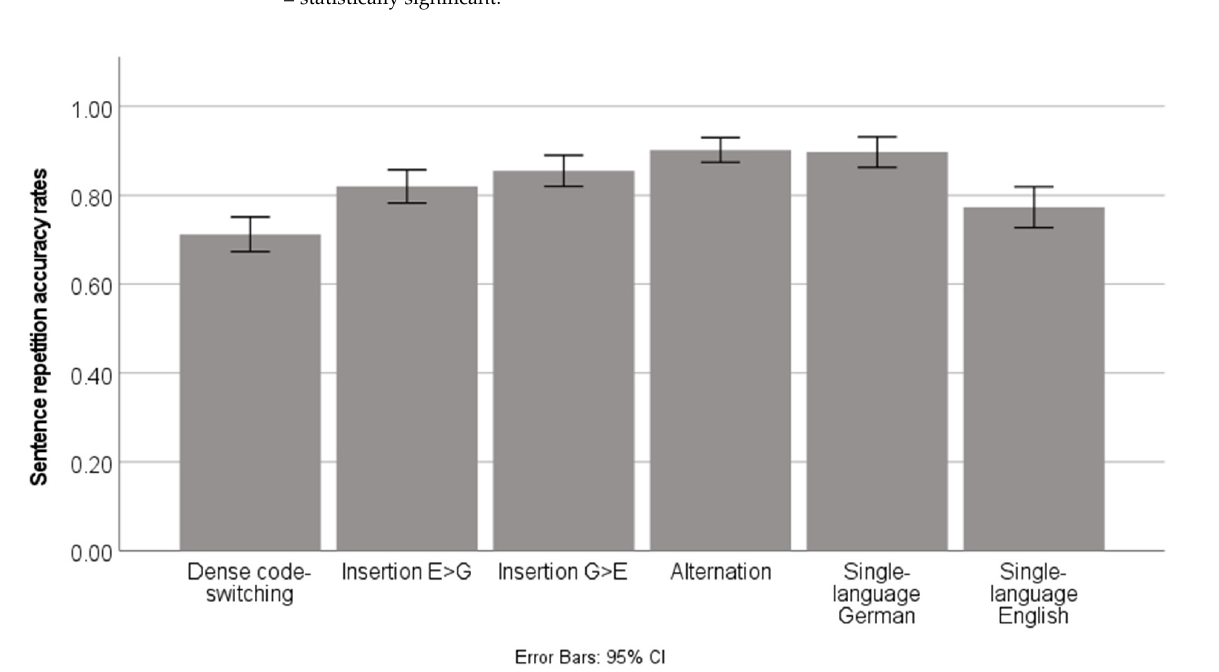
Figure 1. Sentence repetition accuracy by sentence type.